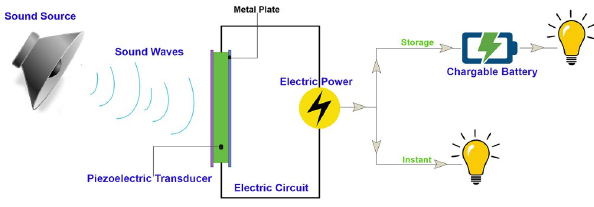
Fig 4. A diagram of sonic energy conversion process. (Researcher,